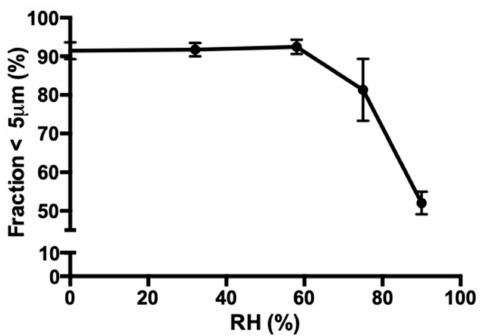
Figure 8. The change in the fraction < 5 µ m of the 5% l -leucine formulation as a result of storage at di ff erent relative humidities (RHs) at 25 ◦ C for 48 h. Each sample was spray dried twice and each laser di ff raction measurement was performed three